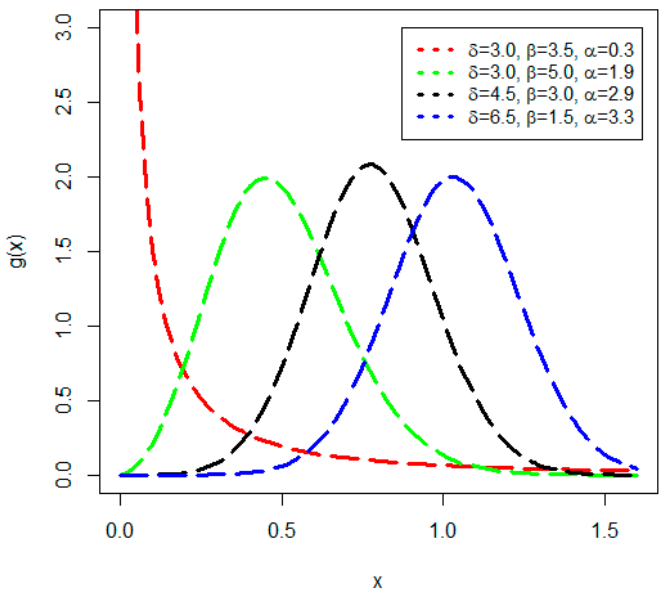
Figure 2. Plots of the g ( x ; δ , Θ ) PDF of the NGLog–Weib model. ( ) ; , g x δ Θ PDF of the NGLog–Weib model.